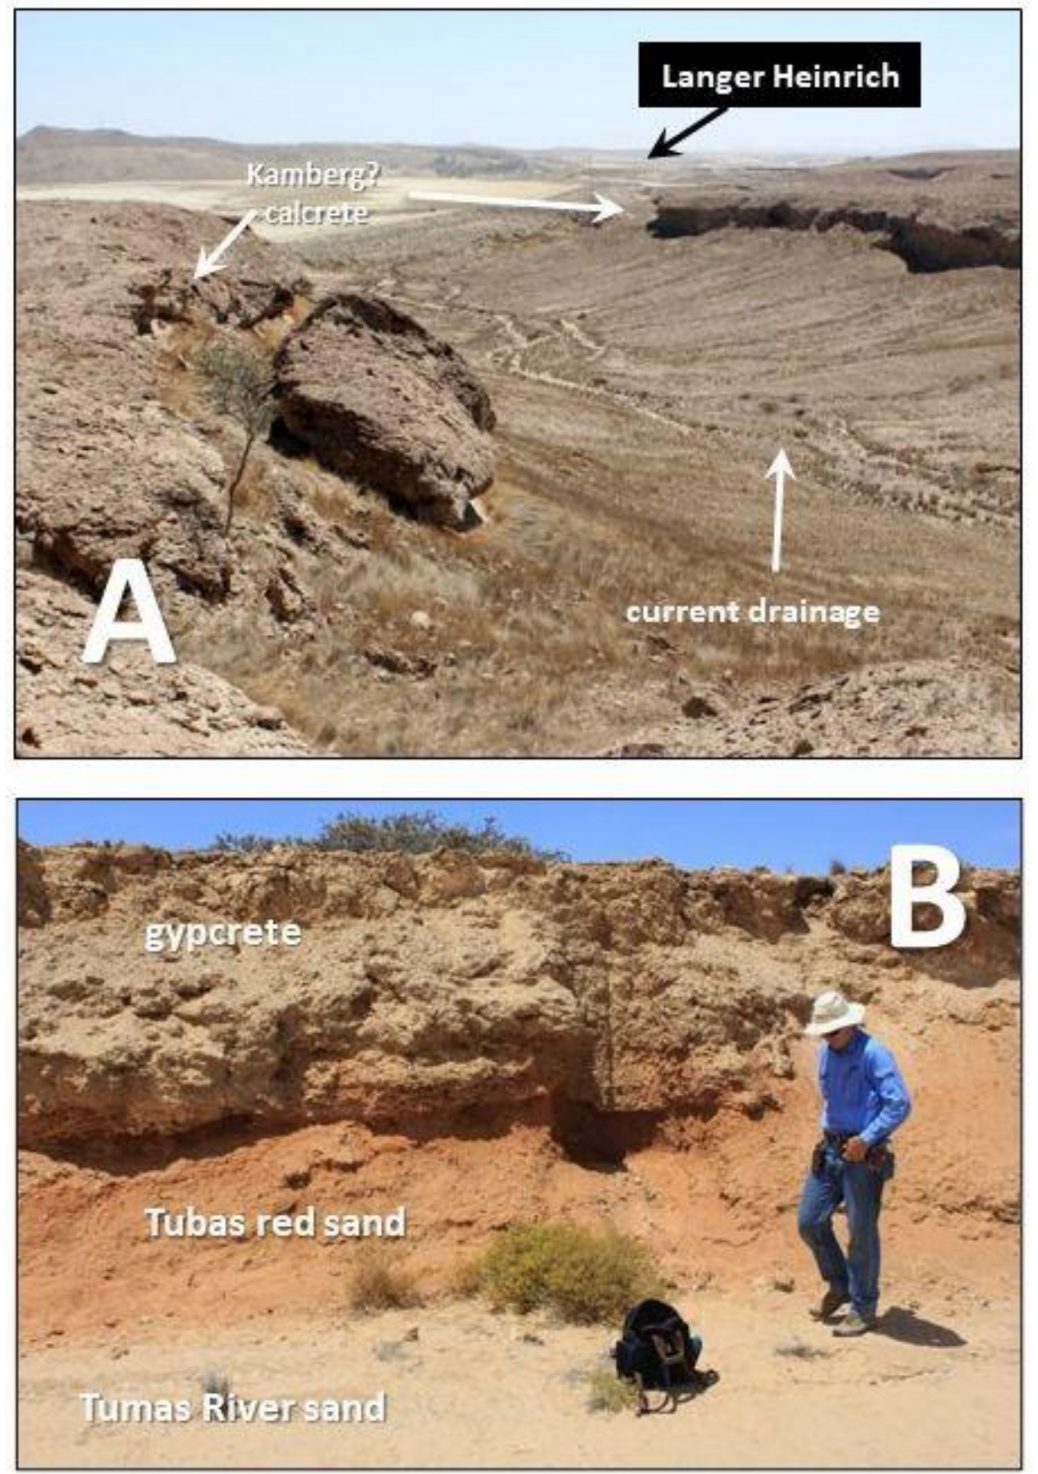
Figure 3. ( A )—Looking westwards down the Langer Heinrich Valley showing relict calcrete deposits above the present level of the Gawib River and the uranium deposits. Hills in distance are formed by outcrops of Tinkas Formation schist. ( B )—Rare outcrop of Tubas Red Sand overlain by gypcrete at the Tumas River. The scarp in this image is due to incision by the active Tumas River and shows that the gypcrete formation predates the Tumas